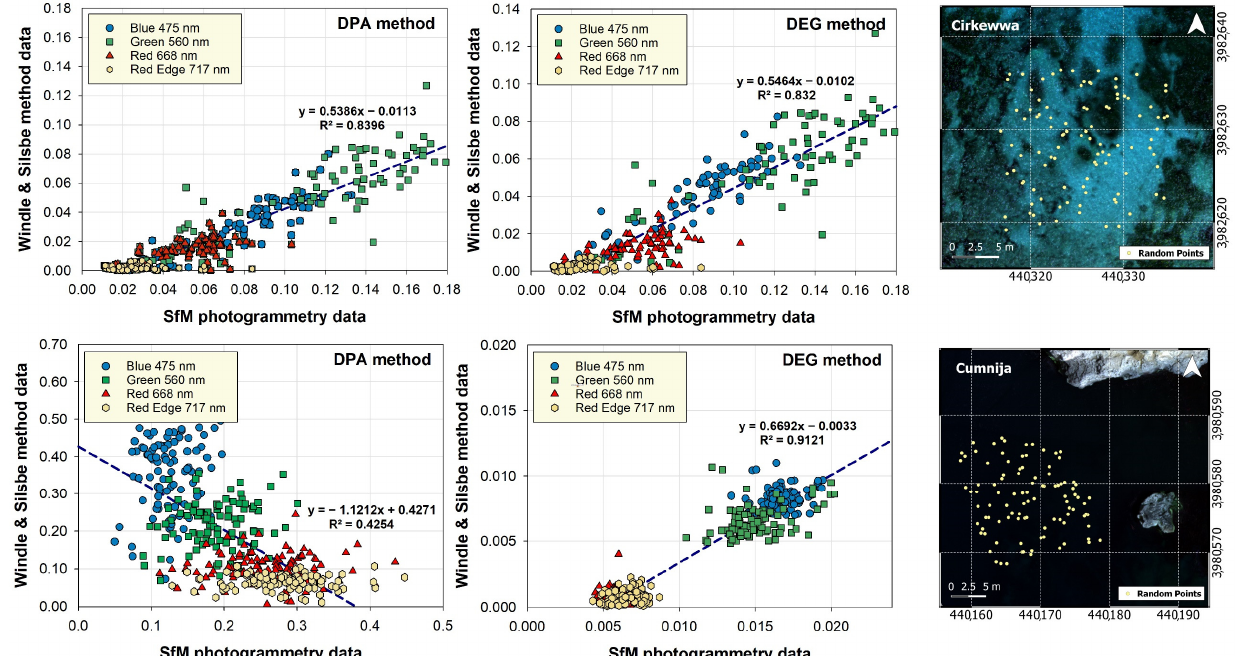
Figure 3. Pixel-by-pixel and band-by-band comparison between Rrs data (dimensionless) obtained by the DPA and the DEG methods, respectively, and the UAV photogrammetry. One hundred pixels ( n = 100) were randomly selected and are also displayed in the figure.